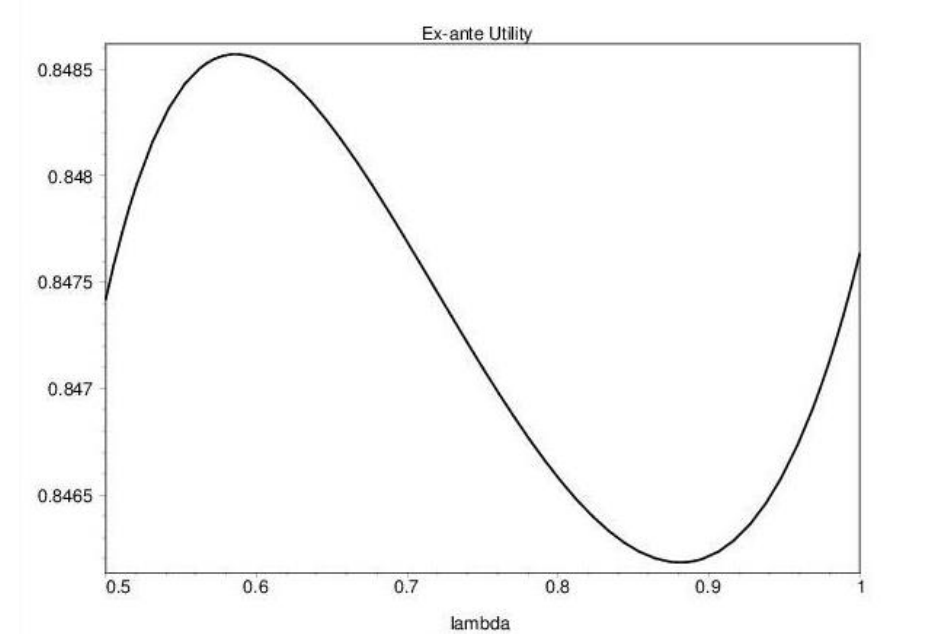
Figure 3. Case of concave utility function. Parameters: θ L = 1, θ H = 1 . 5, π = 0 . 8, a=0.4, a ( k ¯ − k i ) =